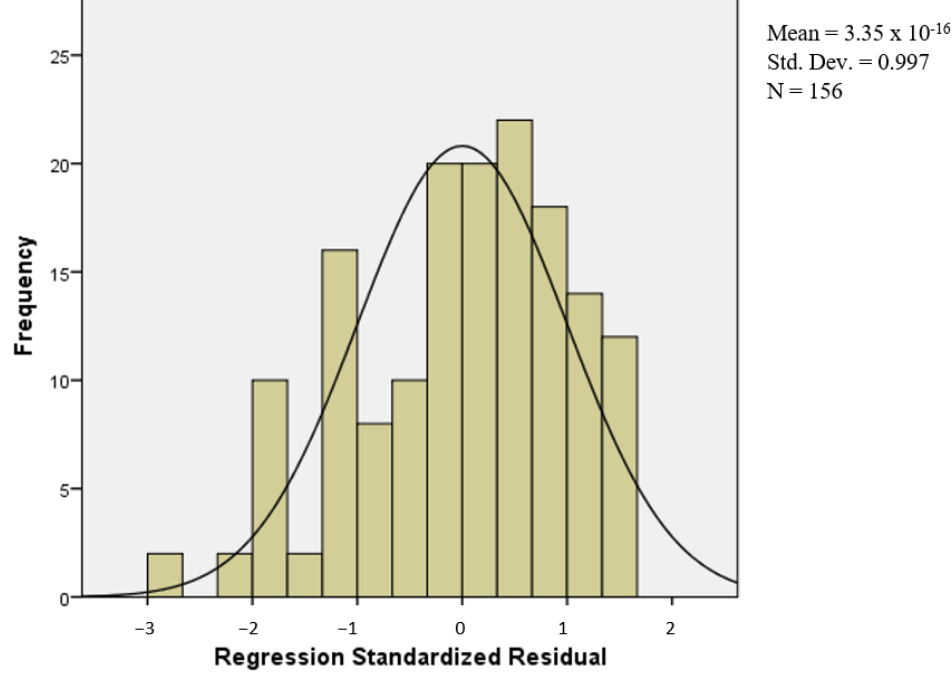
Figure A2. Histogram using physical health as the dependent variable.